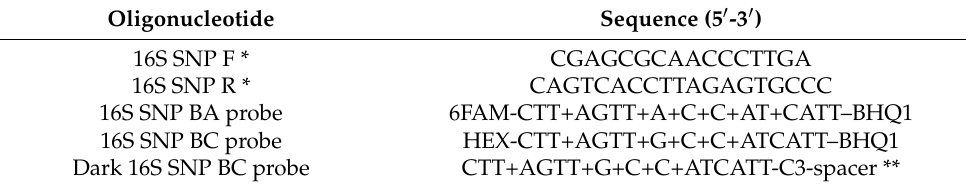
Table 1. Primers and